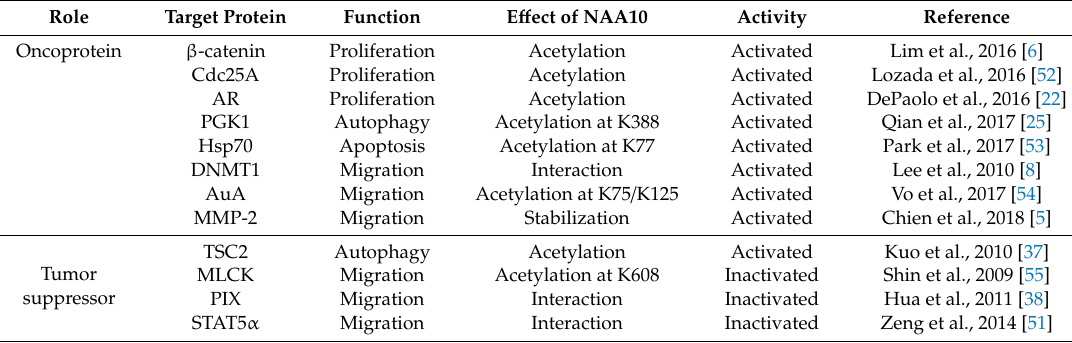
Table 2. The role of NAA10 and its regulatory e ff ects on target proteins in cancer